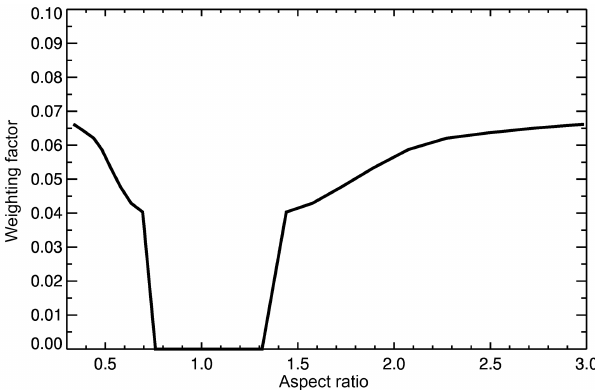
Figure 4. Aspect ratio ( ε ) weighted distribution for aerosol spheroid polydispersion.